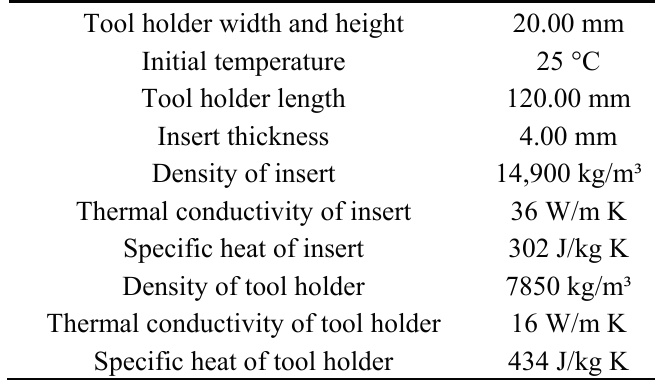
Table 6. Input values of the FEA (finite element analysis) model for the cutting tool.